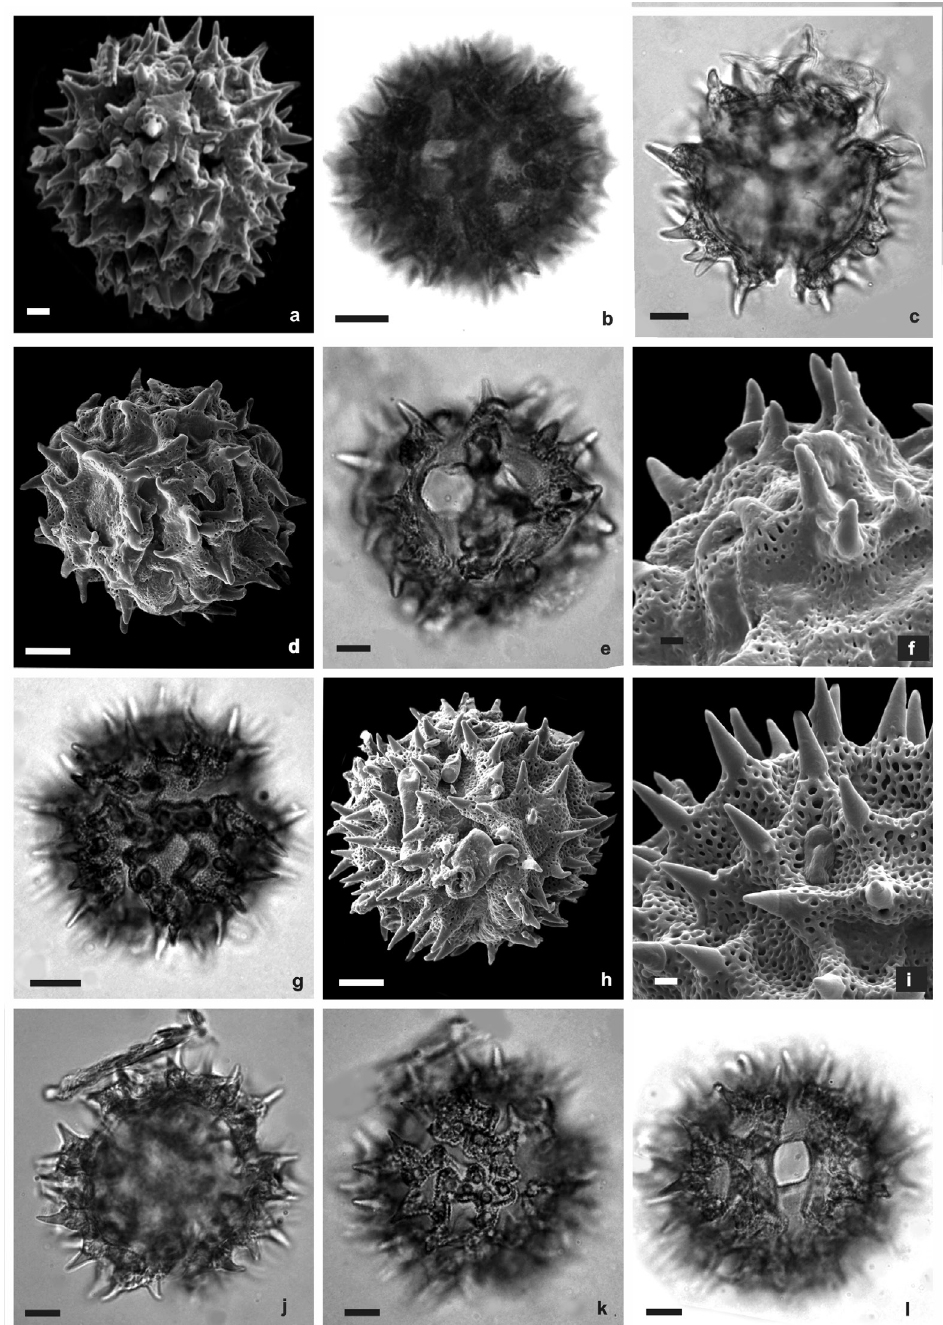
Figure 3. Light microscopy (LM) and scanning electron microscopy (SEM) images of pollen grains of Piptolepis species. P. leptospermoides - a. polar view, general aspect (SEM), b. equatorial view, aperture (ML). P. monticola - c. polar view, optical section (ML), d. polar view, apocolpus (SEM), e. equatorial view, aperture (ML), f. surface detail (SEM). P. oleaster - g. polar view, surface (ML), h. equatorial view, aperture (SEM), i. surface detail (SEM). P. schultziana - j. polar view, optical section (ML), k. general aspect, surface (ML), l. equatorial view, aperture (ML). Scale bar: 5 µm (a-e, g, h, j-l), 1 µm (f,